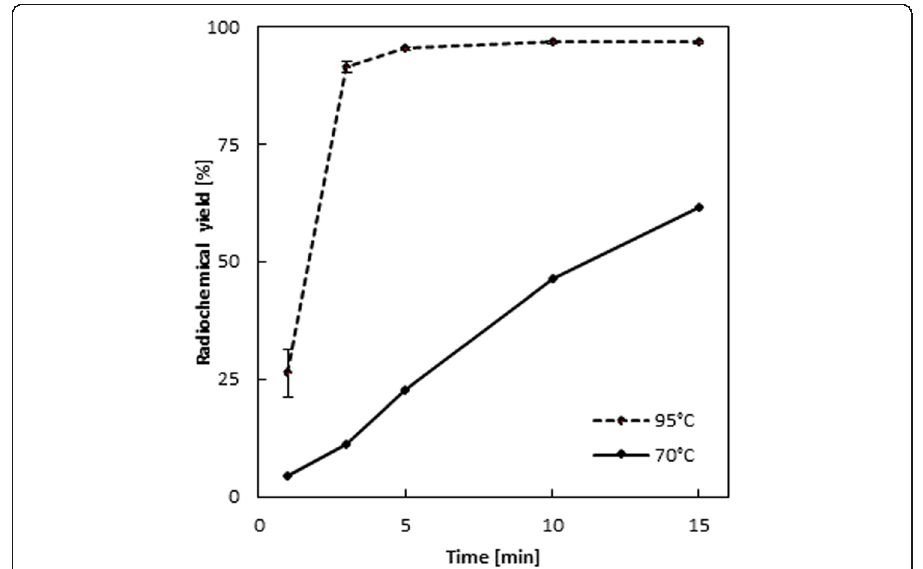
Fig. 1 Baseline labeling kinetics of 68 Ga-DOTATOC in pure aqueous solution at 70 and 95 °C (10 nmol/2.93 μ